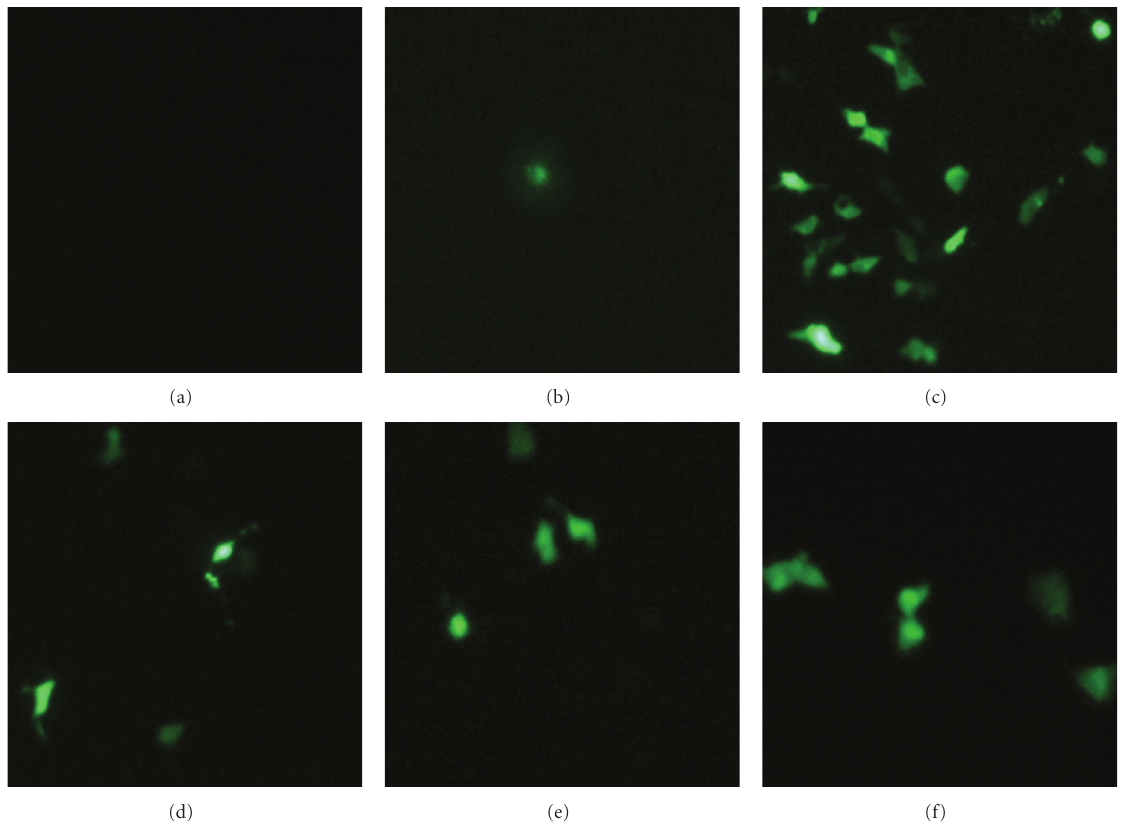
Figure 2: Fluorescent microscopy of GFP expression in COS-7 cell lines transfected with di ff erent gene carriers. Fluorescent cells were visualized at 48h post-transfection. (a) Untreated, (b) naked DNA, (c) PEI/phMGFP, (d) D-SPM/phMGFP at ratio 12, (e) D-SPM/phMGFP at ratio 14, and (f) D-SPM/phMGFP at ratio16. (Magnification x10).